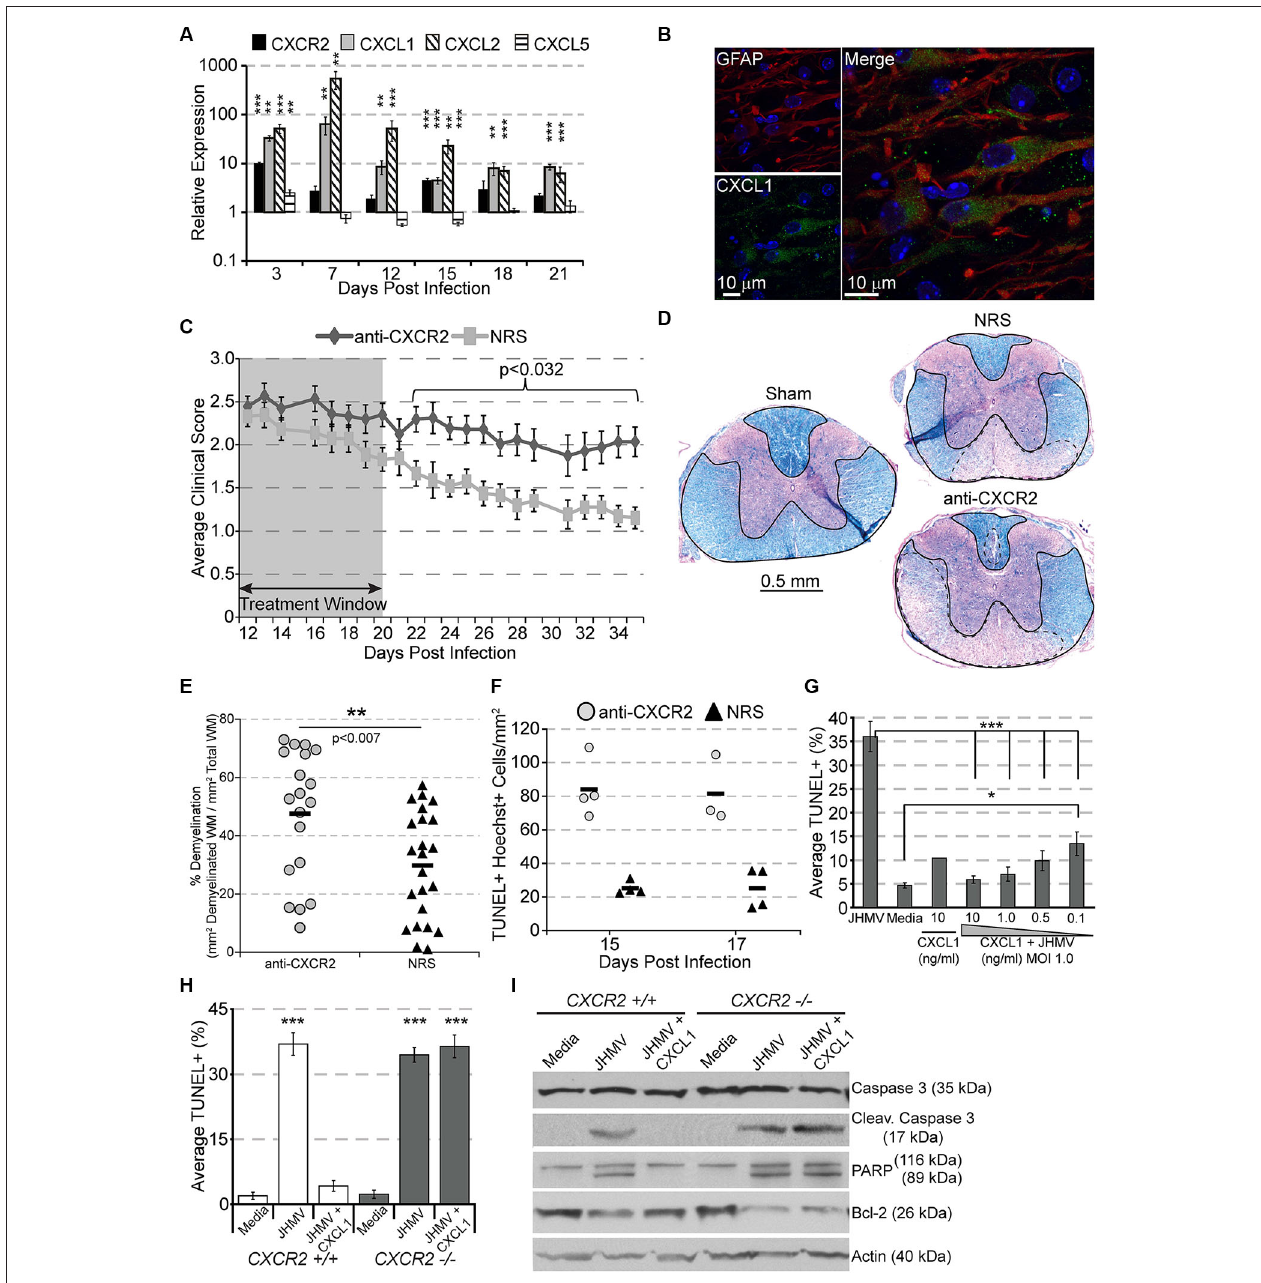
are shown in panel (D) with the total (solid line) and demyelinated (dashed line) white matter indicated. (F) Significantly ( p < 0.001) increased numbers of apoptotic (TUNEL+) cells were observed within the spinal cords of anti-CXCR2 treated mice. (G) CXCL1, in a dose-dependent manner, protects oligodendrocytes from apoptosis, and (H) CXCR2-deficienct oligodendrocyte-enriched cultures are not protected from apoptosis. (I) Protein lysates from CXCR2-sufficient and CXCR2-deficient oligodendrocyte cultures were assessed via western blot for total caspase 3, activated caspase 3, PARP, Bcl-2, and actin expression. NRS = normal rabbit serum treated mice. * p < 0.05, ** p < 0.01, *** p < 0.001 compared to NRS-treated